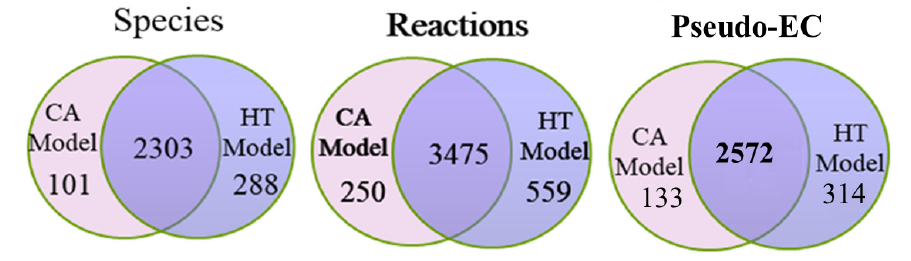
Figure 4. Statistics of cancer (CA) and healthy (HT) metabolomic models. Numbers of genes, species, and reactions for CA and HT models reconstruted by the CORDA algorithm taking the Recon 2.2 general model and HPA protein expression data as input. The basal (BL) model is composed of the union set of HT and CA